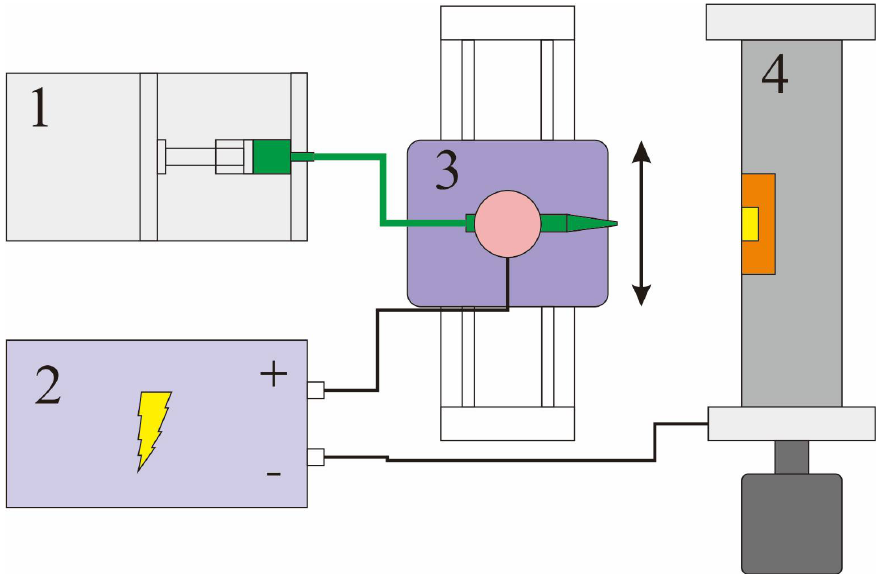
Figure 5. The diagram of fabrication system of aligned SMFs on FPCB based on electrospinning device. Number 1 is a syringe pump, 2 is a high voltage generator, 3 is a linear motion stage and 4 is a motor-driven aluminum drum with FPCB attached.